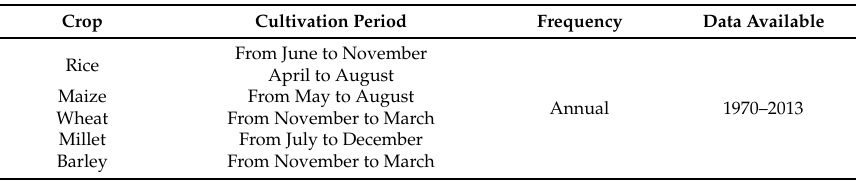
Table 2. Considered crops and cropping